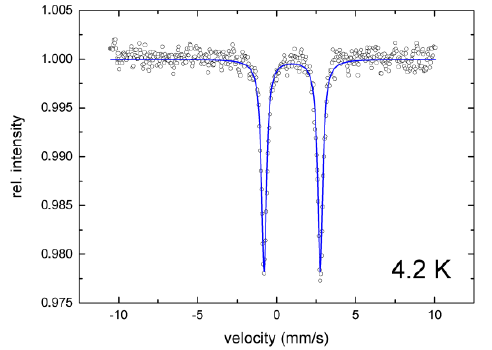
Figure 8. 57 Fe-Mössbauer spectrum of a microcrystalline sample of complex 4 .